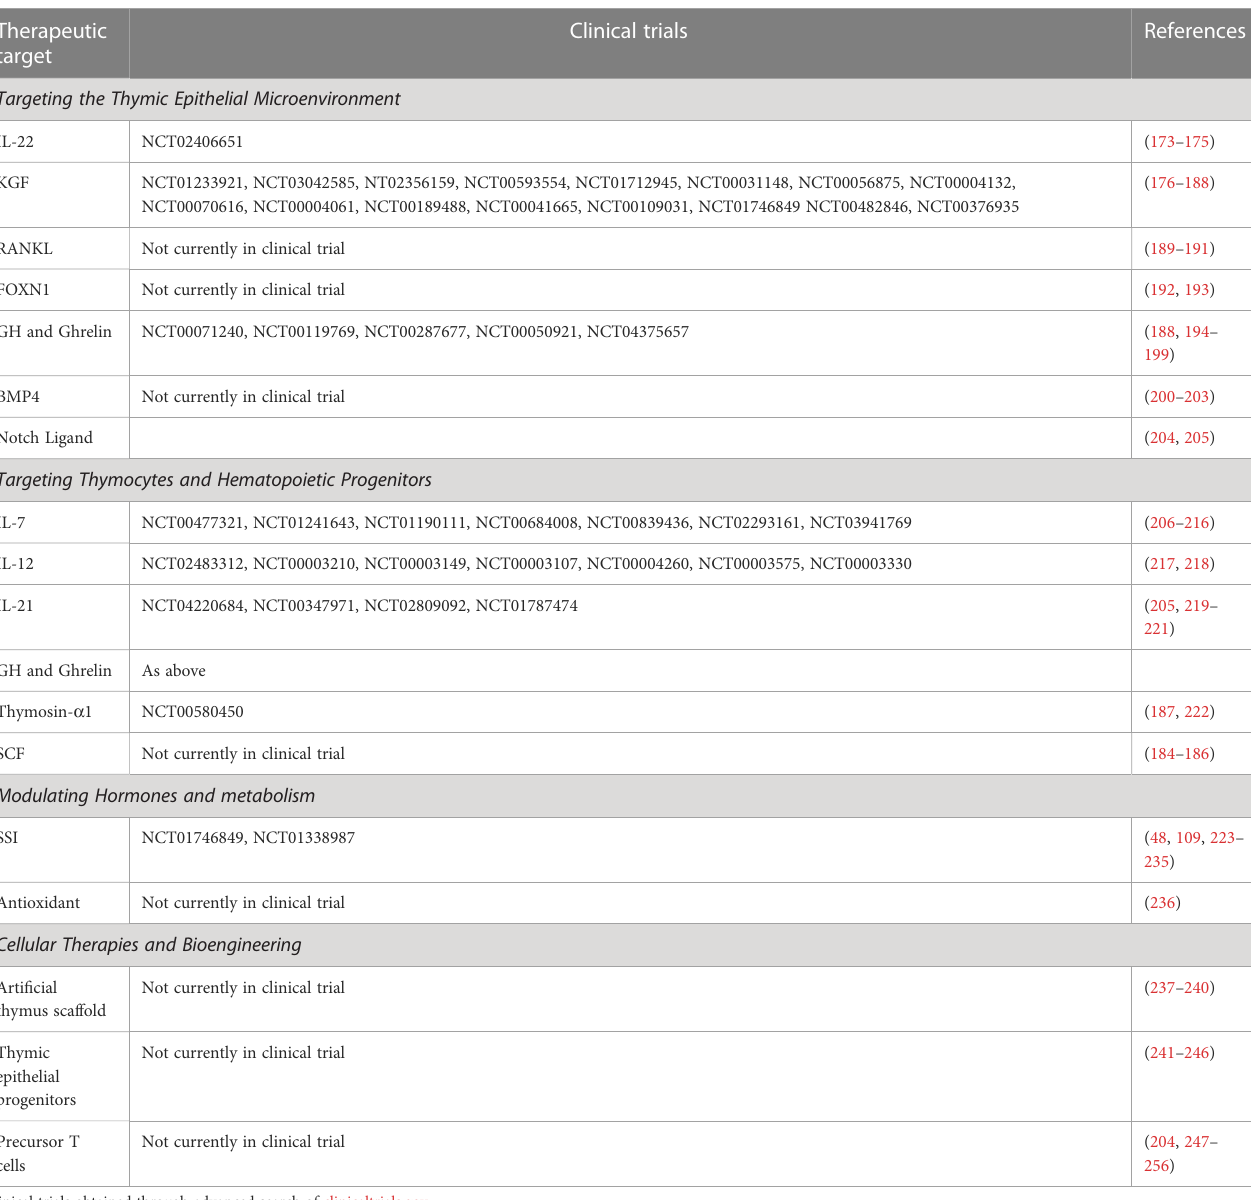
TABLE 1 Current approaches to Thymic/T cell regeneration in AML and other hematologic